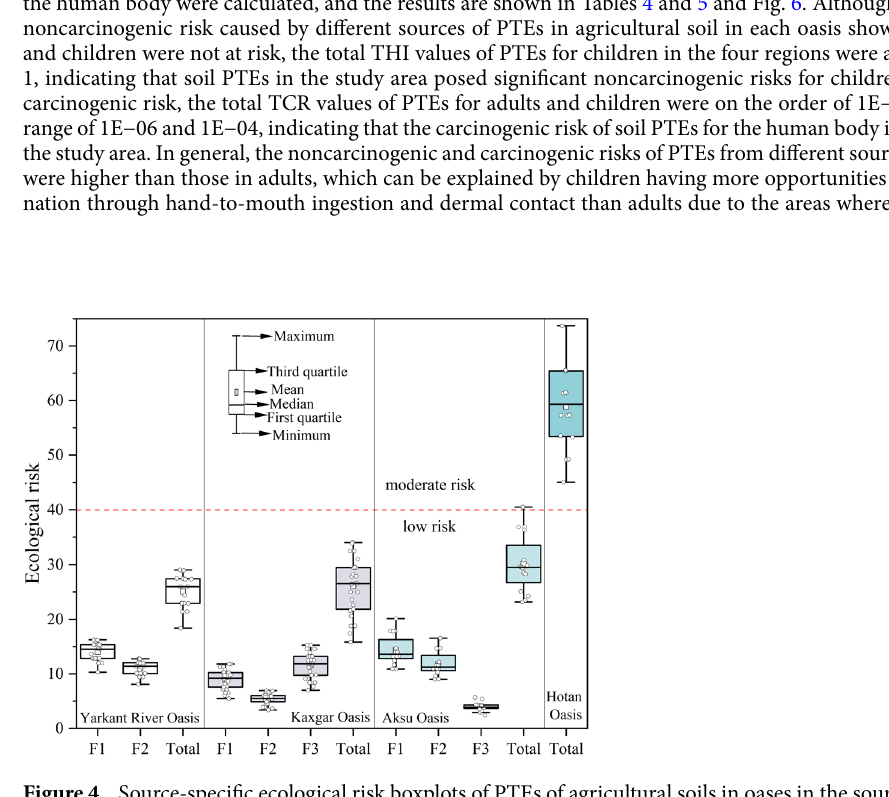
Figure 4. Source-specific ecological risk boxplots of PTEs of agricultural soils in oases in the source region of the Tarim